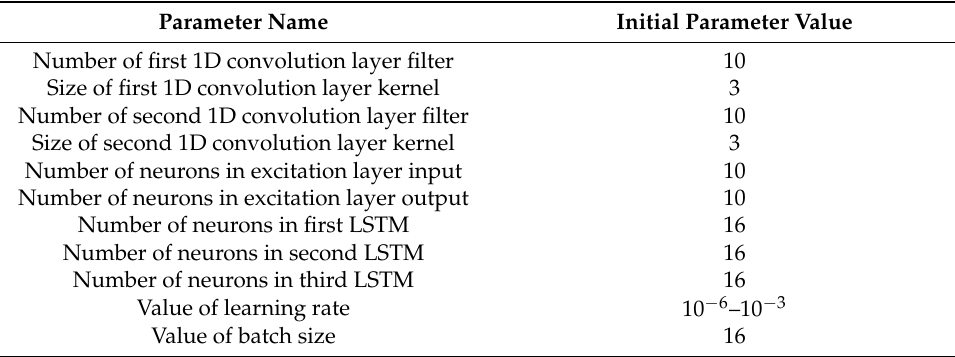
Table 2. Initial parameters of the CNN-LSTM with the SE model.